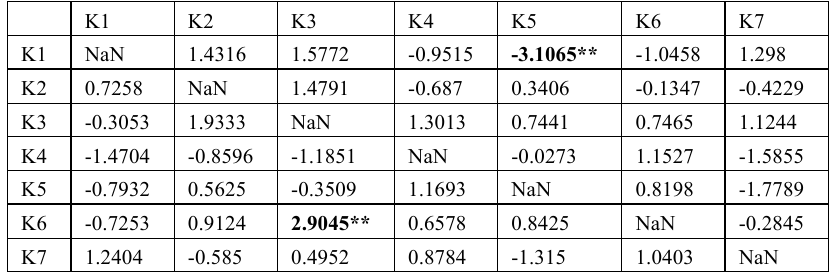
Two-sample t test during RR in the NI